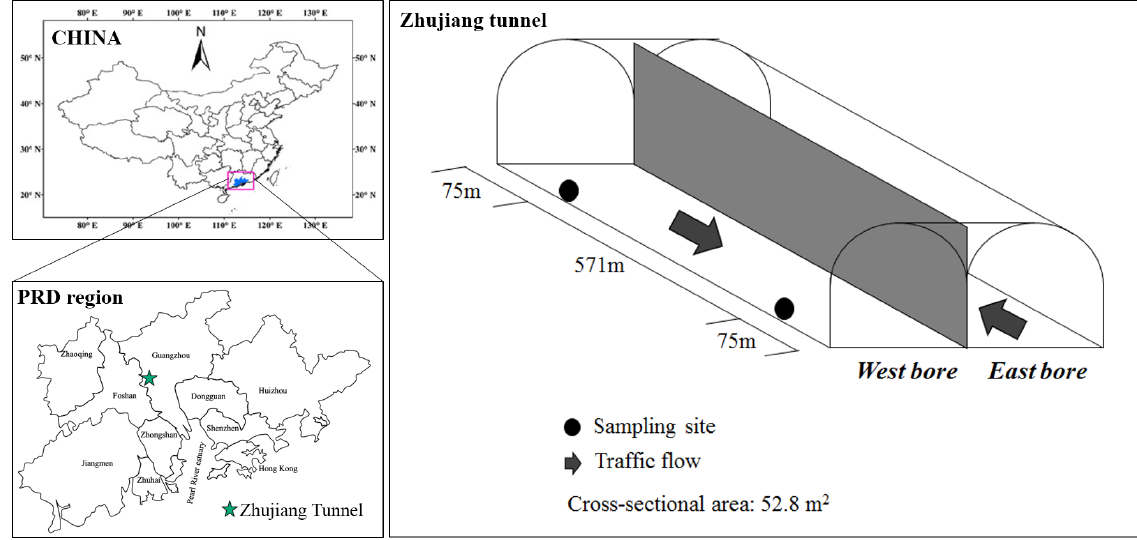
Figure 1. Sampling schematic diagram of the Zhujiang